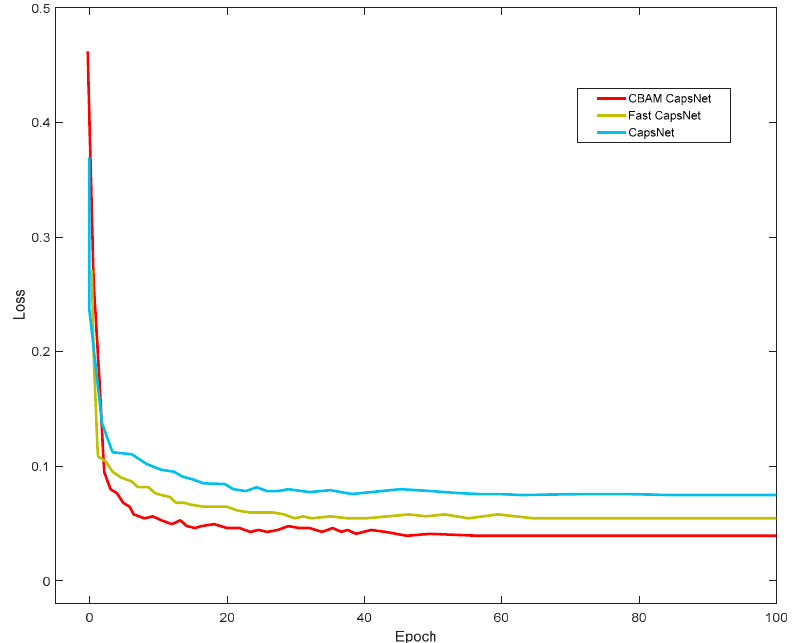
Figure 10. The relationship between the loss and epochs.